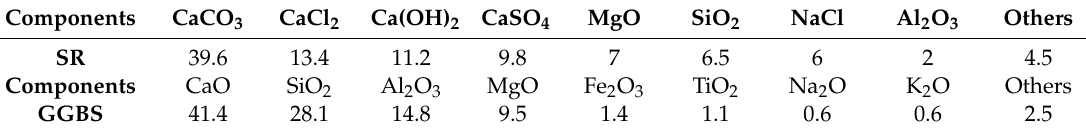
Table 1. Chemical compositions of SR and GGBS used in this study (wt.%).